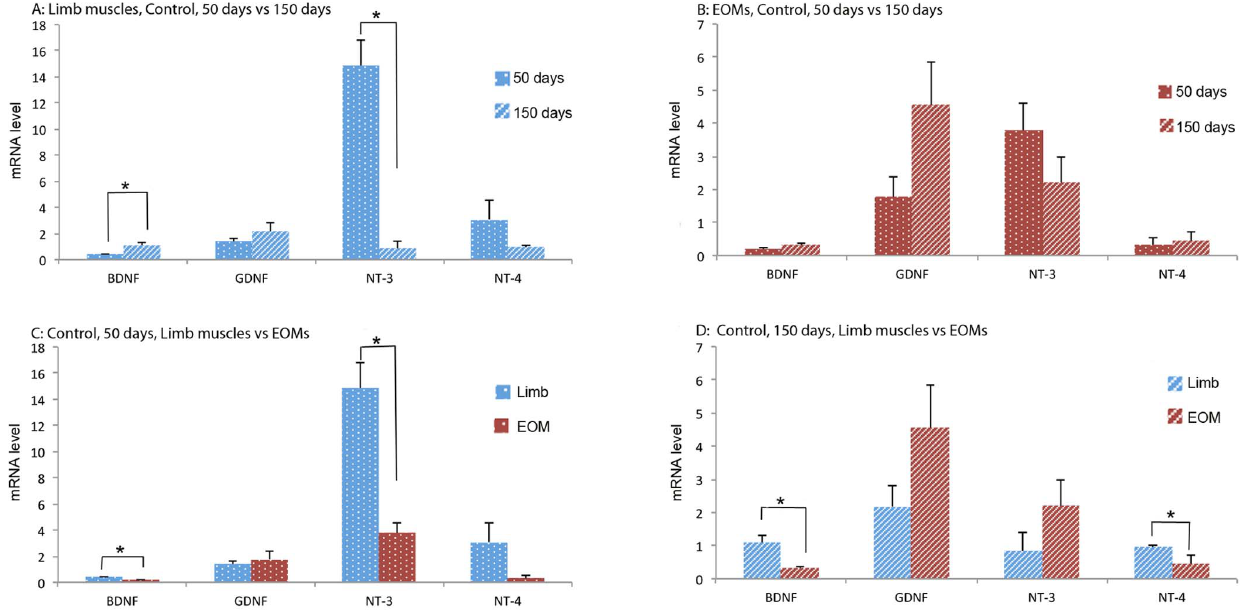
Figure 2. mRNA levels of NTFs in limb muscles and EOMs from 50 days and 150 days control mice. Top panels: comparison of NTFs expression in limb muscles (A) and EOMs (B) between 50 days and 150 days. Bottom panels: comparison of NTF expression between limb muscles and EOMs of 50 days (C) and 150 days (D). The expression levels are given using arbitrary units normalized by b -actin expression. Bars represent mean 6 SD from analysis of at least 5 separate samples run in triplicate. *: p , 0.05.